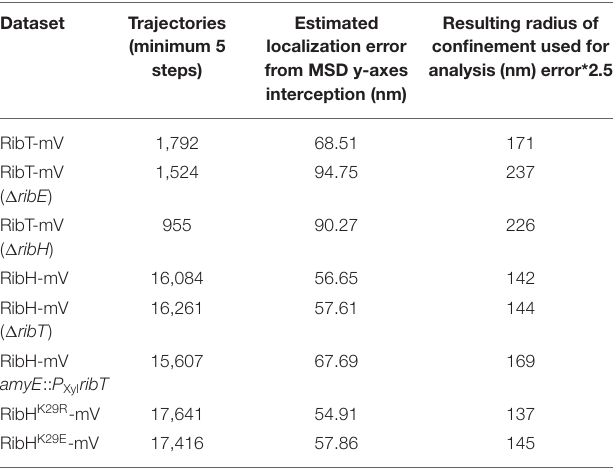
TABLE 3 | Mean estimated localization errors and radii of confinement for each SPT dataset used in this